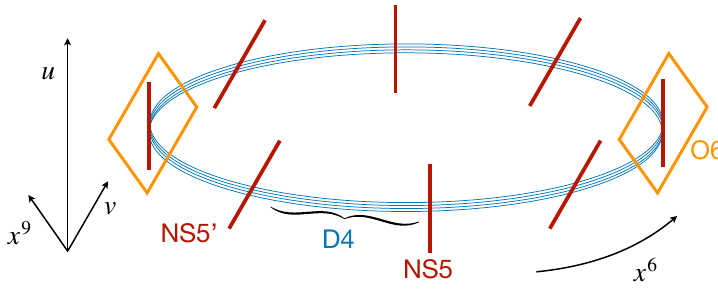
Figure 5 . IIA picture of an elliptic model with O6-planes. The low-energy effective quiver theory can have orthogonal and/or symplectic gauge